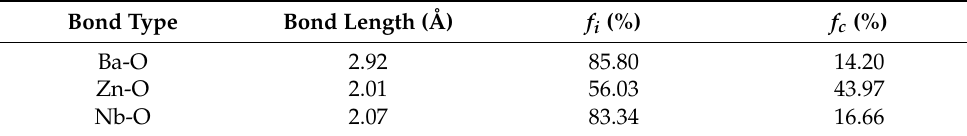
Table 3. The bond ionicity ( f i ) and bond covalency ( f c ) of Ba(Zn 1/3 Nb 2/3 )O 3 ceramics. Bond